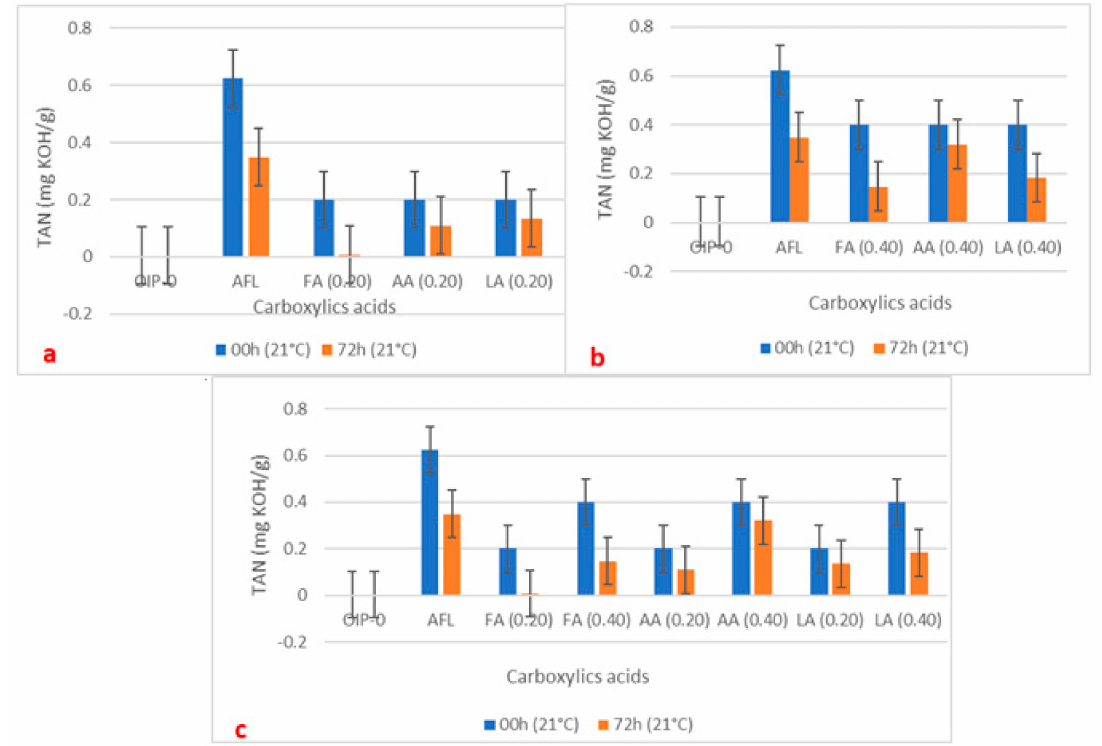
Figure 2. Acidity comparison before and after 72 h of exposure at room temperature: ( a ) 0.20 mg KOH/g and ( b ) 0.40 mg KOH/g for three different acids (formic, acetic and levulinic), acid mixture and also for acid-free oil. The results are summarized in Figure ( c ) for better